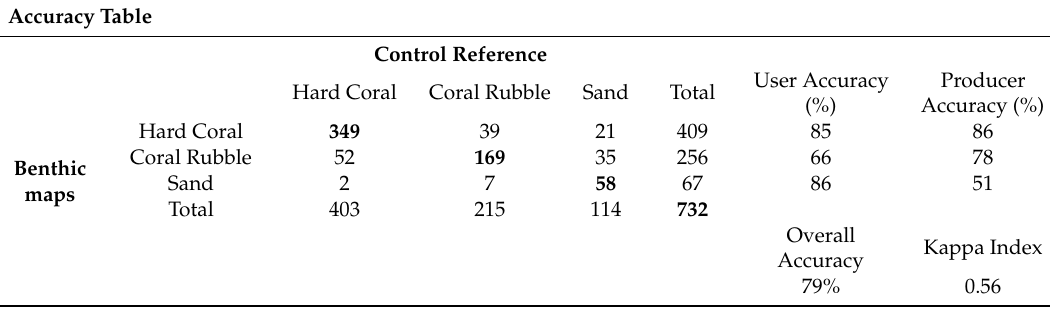
Table 2. Confusion matrix and accuracy index for the classified maps.